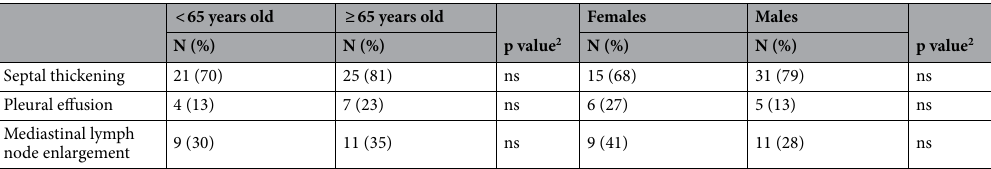
Table 3. Differences across groups dividing patients according to age and gender. CT computed tomography, WBC white blood cells, ANC absolute neutrophil count, ALC absolute lymphocyte count, AMC absolute monocyte count, N:L neutrophils:lymphocytes, Hb haemoglobin, PLT platelets, ESR erythrocyte sedimentation rate, CRP C reactive protein, LDH lactate dehydrogenase. 1 p value calculated with Mann Whitney U test. 2 p value calculated with the χ 2 test or the Fisher’s exact test as